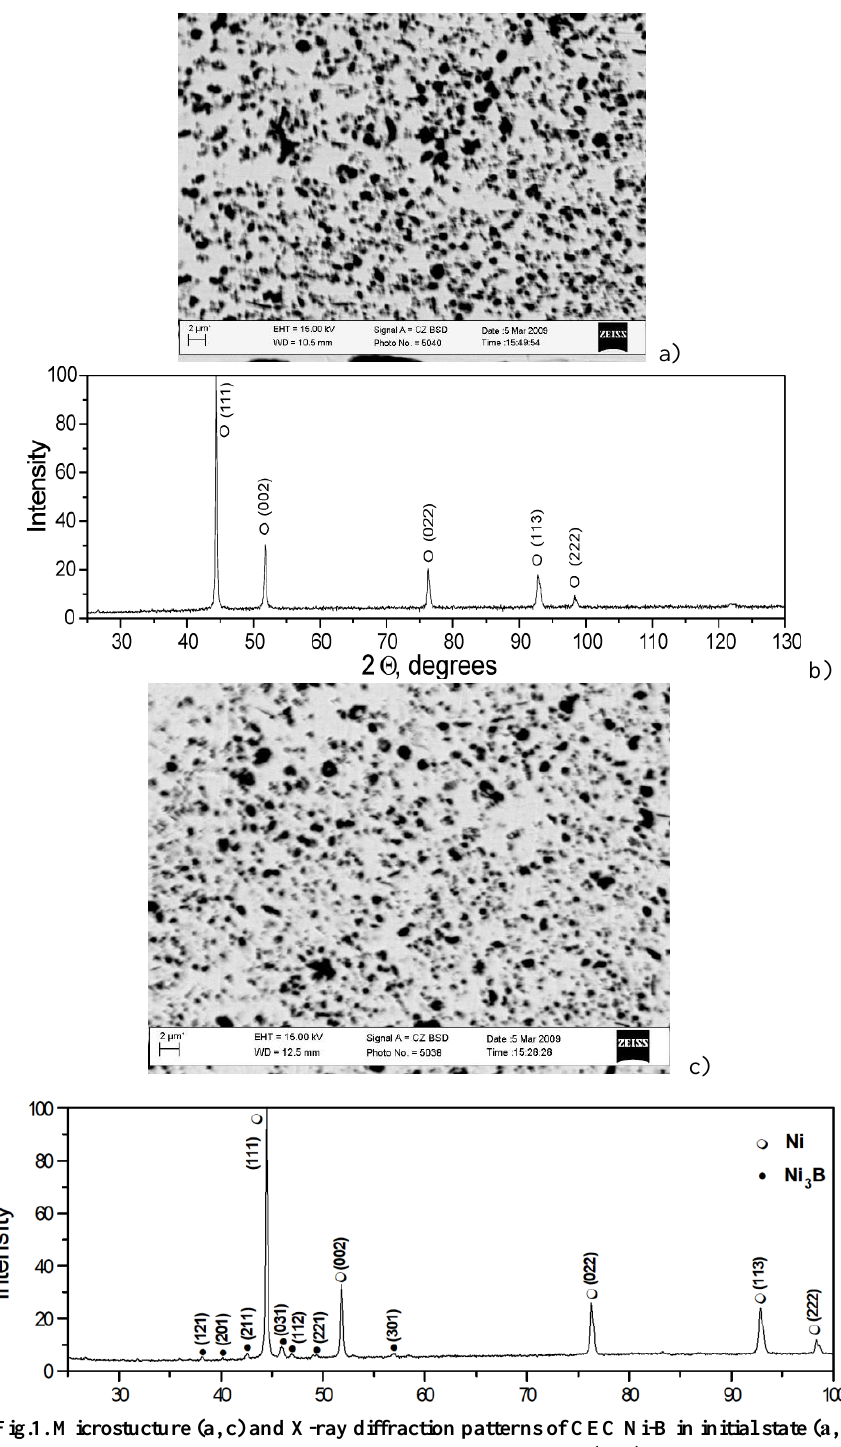
Fig.1. Microstucture (a, c) and X-ray diffraction patterns of CEC Ni-B in initial state (а, b) and after thermal treatment at 450  С (c,